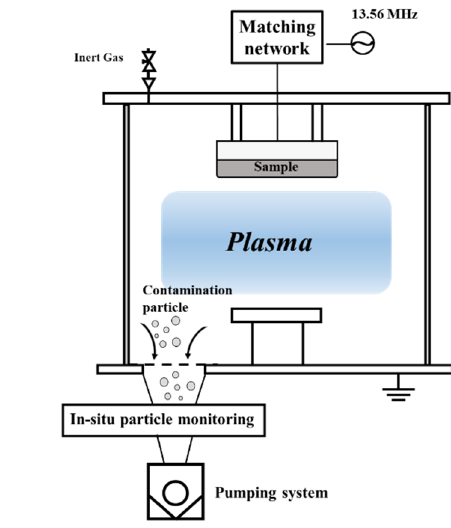
Table 2. Plasma-etching conditions.